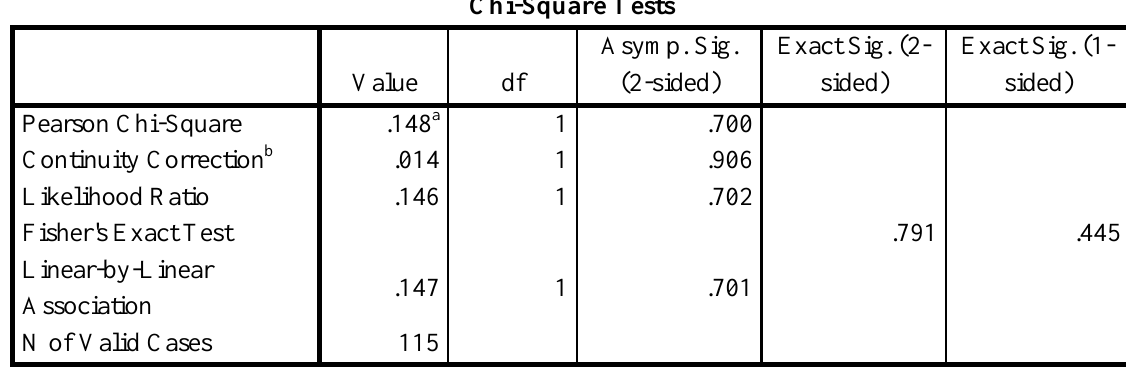
Table 4. Che-Square Test for two nominal variables